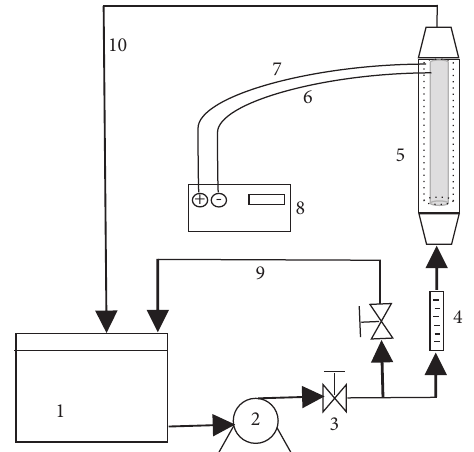
Figure 2: Schematic diagram of the laboratory-scale setup: (1) sample tank, (2) pump, (3) valve, (4) rotameter, (5) tubular reactor, (6) anode wire, (7) cathode wire, (8) DC power supply, (9) recycle, and (10) treated effluent flow.